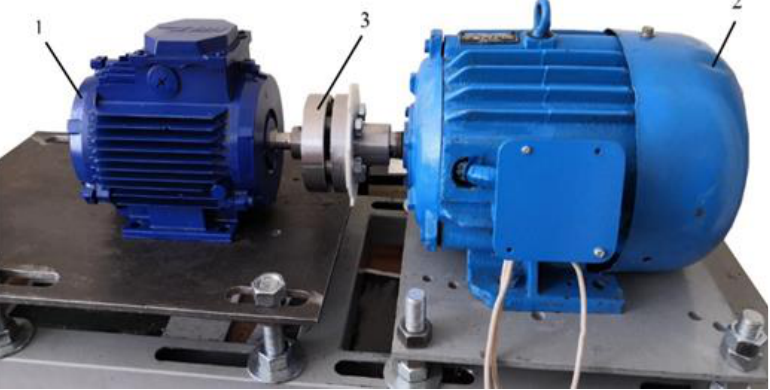
Figure 12. Experimental assembly for the investigation of tangential and radial machines in the la-